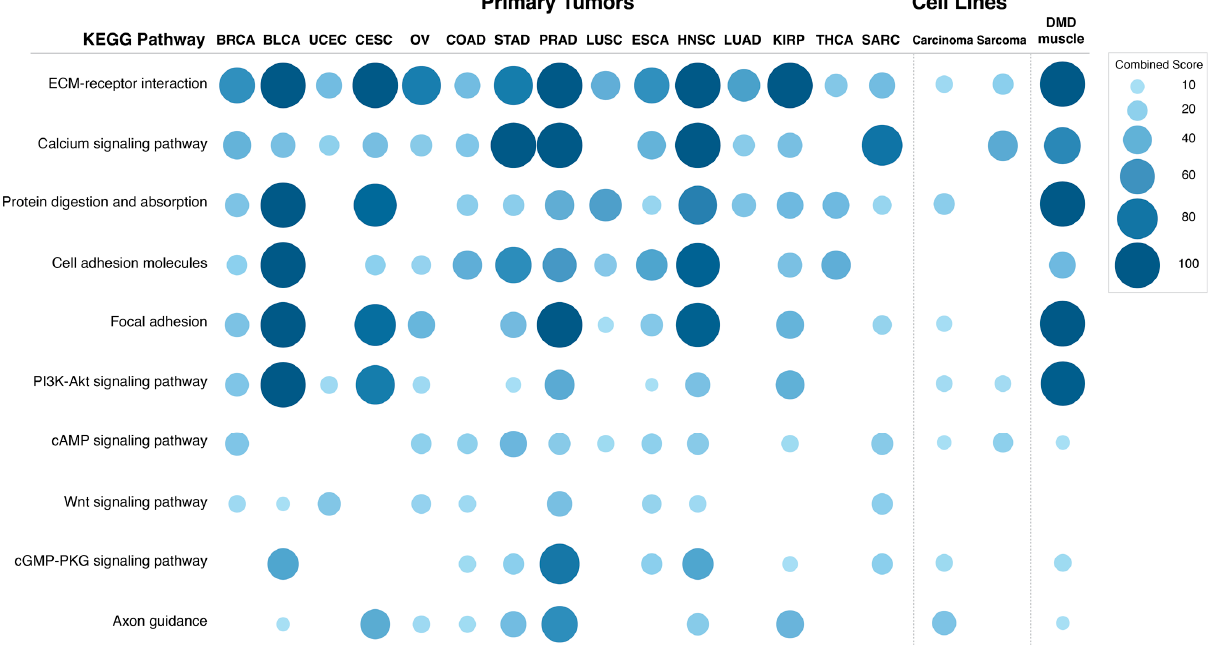
Figure 6. KEGG pathways enriched in the DEGs in primary tumor samples and tumor cell lines with low vs. high DMD gene expression as well as in DMD skeletal muscle. Only pathways that were identified in more than 50% of primary tumor samples with low DMD expression are displayed (adjusted p -Value < 0.05). Data is represented as the combined score for the enrichment ( − Log ( p -Value) × odds ratio). Combined score values greater than 100 were given a value of 100. The differentially expressed transcripts in tumors with low DMD expression showed enrichment in the ECM-receptor interaction pathway in all 15 primary tumors analyzed.